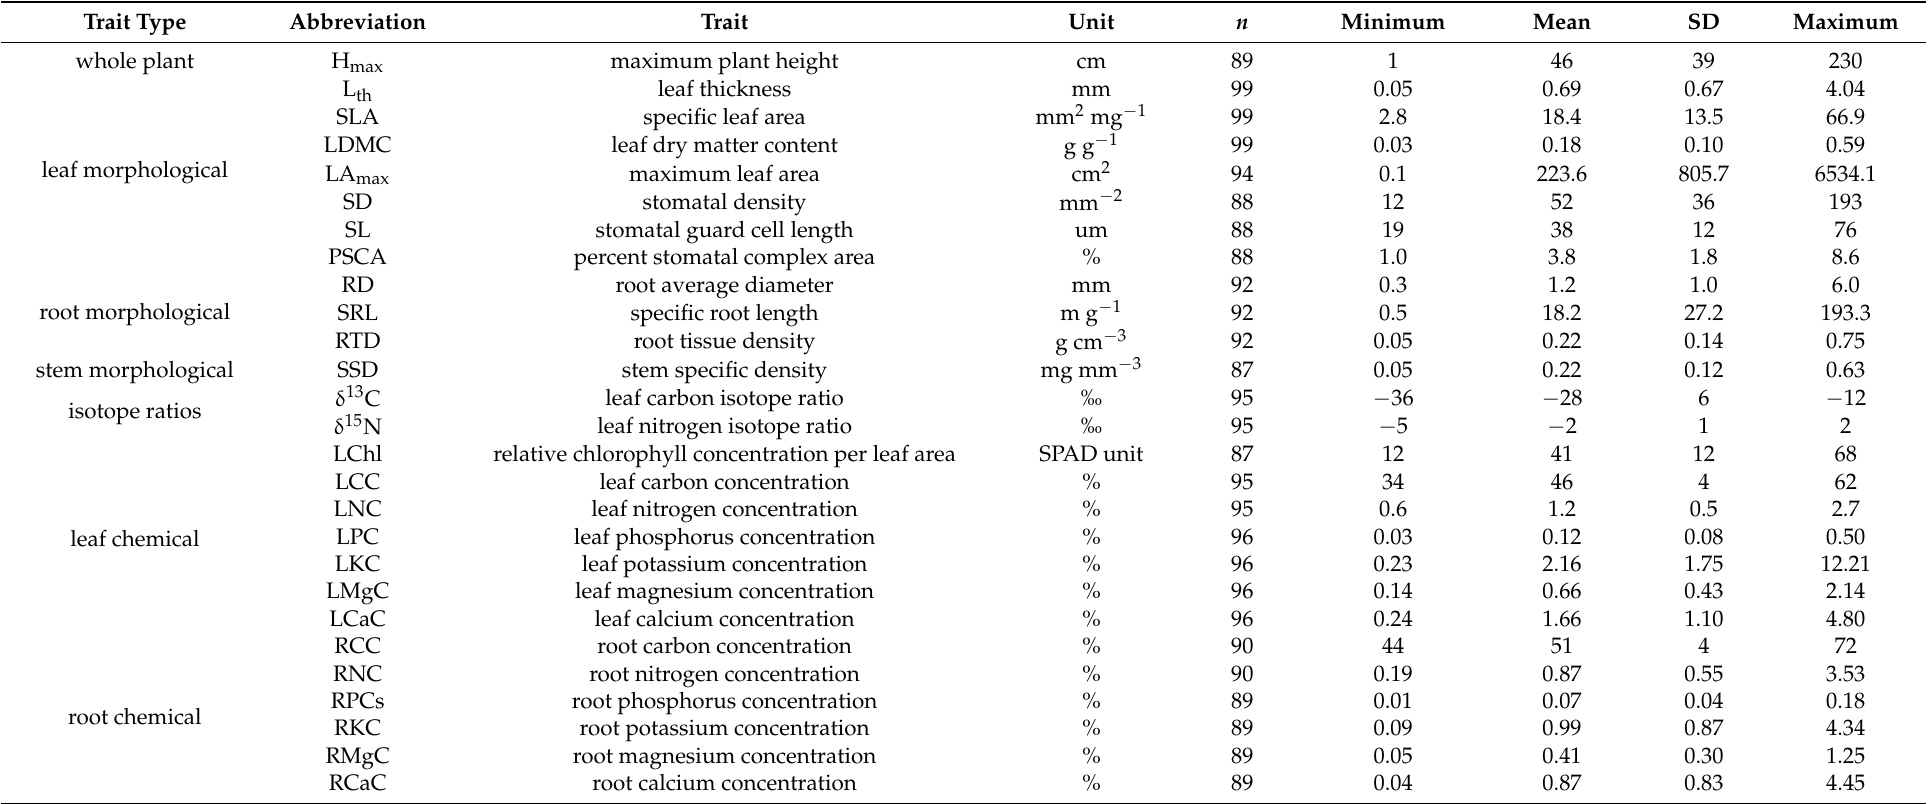
Table 1. Summary of the 28 studied traits. For each of the 27 continuous traits, which are sorted by trait types, an abbreviation, the number of studied species ( n ), minimum, mean, standard deviation (SD), and maximum values are given. A 28th trait (PP, CAM vs. C3 pathway) is not shown. Sample size varies because it was not possible to determine all traits in every species. “Minimum”, “Mean”, “SD”, and “Maximum” refer to respective parameters for the whole assemblage, generally determined with average trait values per species. In the case of plant height and leaf area, the species values (H max , LA max ) are the largest values observed in a given